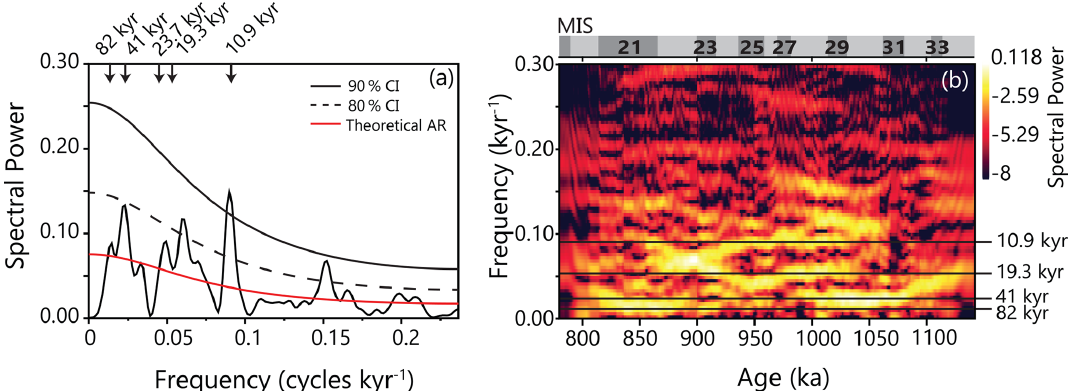
data from 1142 to 752ka. (a) Lomb–Scargle periodogram, with the 80% and Figure 4. Frequency analysis of Lake El’gygytgyn MBT (cid:48) 5ME 90% confidence levels as well as the theoretical autoregression levels. (b) Short-time Fourier transformation showing the evolutionary power spectrum, with the dominant peaks from (a) indicated with horizontal lines. Marine Isotope Stage (MIS) are indicated along the top. Both analyses were performed using PAST3 (Hammer et al.,